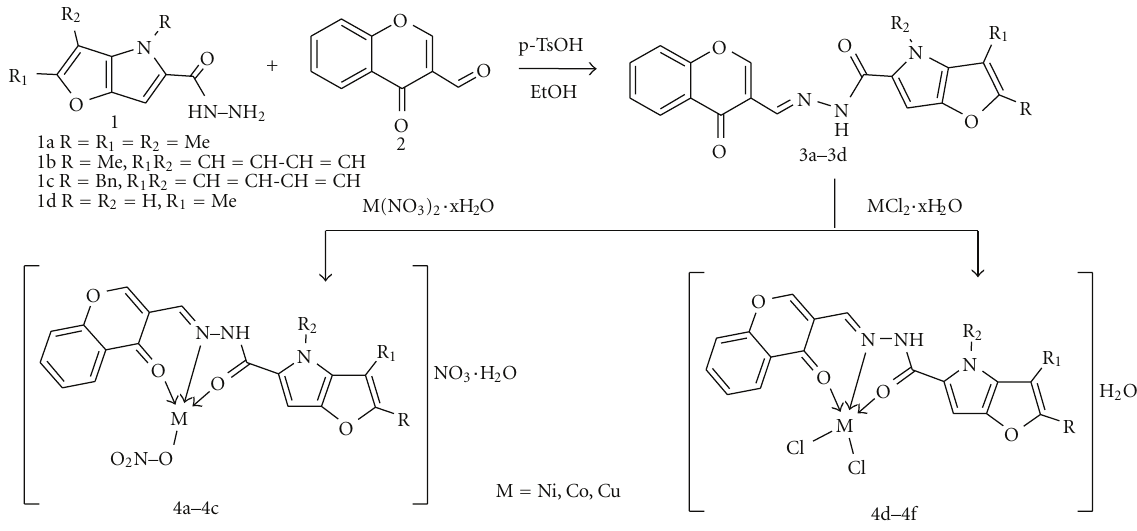
Scheme 1: Synthesis of carboxhydrazides 3 and their complexes 4.